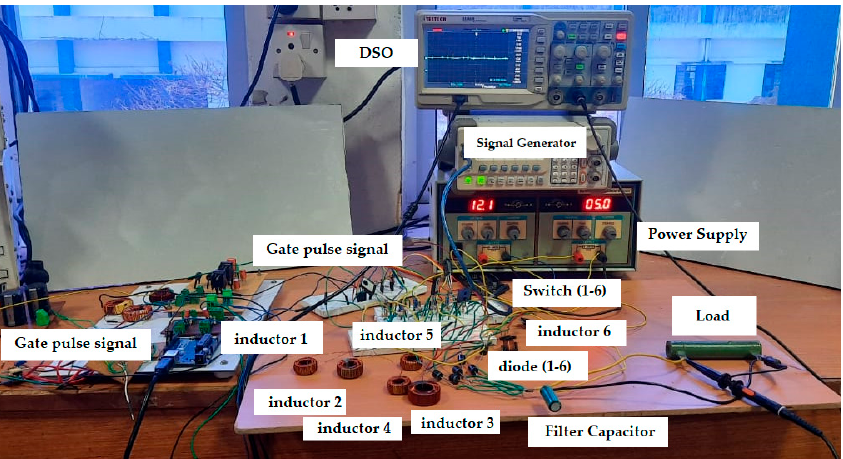
Figure 16. Hardware prototype MPIBC (six phase).